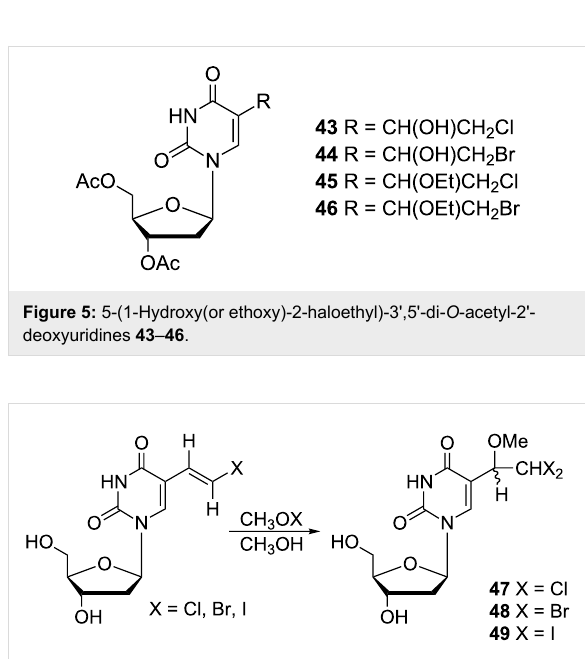
(Scheme 8) and evaluated their antiviral activity [16]. For this purpose, 5-vinyl-2'-deoxyuridine ( 9 ) was used as the starting compound. The regiospecific reaction of the 5-vinyl-2'- deoxyuridine ( 9 ) with iodine monochloride in the presence of various alcohols afforded 2'-deoxynucleosides 50 – 54 in 24–52%